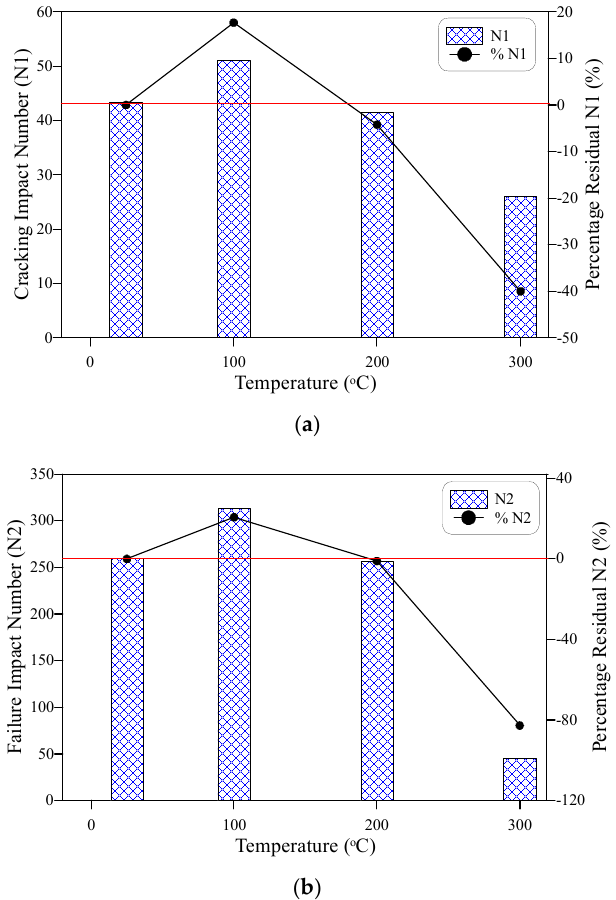
Figure 9. Impact number-temperature behavior ( a ) cracking number N1, ( b ) failure number N2. Following a similar behavior with temperature increase, the failure impact number (N2) of specimens exposed to 100 ◦ C was higher than the corresponding reference unheated N2, as shown in Figure 9b. This increase was also followed by a slight decrease after exposure to 200 ◦ C. However, the decrease of N2 after heating to 300 ◦ C was much higher than its corresponding N1, which reflects the much higher effect of heating at this temperature on the failure impact resistance than the cracking impact resistance. The retained N2 values were 313, 256.7, and 44.7 after exposure to 100, 200, and 300 ◦ C, respectively, while the reference N2 was 259.3 blows. This means that N2 increased by approximately 21% after 100 ◦ C exposure, while almost kept the same as the reference N2 with a slight decrease of 1% after exposure to 200 ◦ C. On the other hand, a serious N2 drop of approximately 83% was recorded for the specimens heated to 300 ◦ C. The higher reduction after exposure to 300 ◦ C is attributed to the microstructural changes that occurred at this temperature, where the complete melting of PP fibers left behind open micro-tubes that composed a network of connected continuous pores, which increased the porosity of the material and made it more brittle. Sahmaran et al. [62] indicated that the increase in PVA-ECC porosity was minimal (0.2%) before fiber melting (200 ◦ C), while the complete melting of fibers increased the porosity to 5% and more after exposure to higher temperatures. Similarly, the increase in pore diameter was minimal after exposure to 200 ◦ C, while the exposure to 400 ◦ C resulted in an increase in pore diameter by about 50%, which explains the minor decrease in N1 and N2 after exposure to 200 ◦ C and the significant decrease after exposure to 300 ◦ C. Bhat et al. [73] reported an increase in the tensile strength of PVA-ECC after exposure to 100 ◦ C, which was attributed to the initial moisture loss due to the free pore water evaporation (form larger pores and capillary